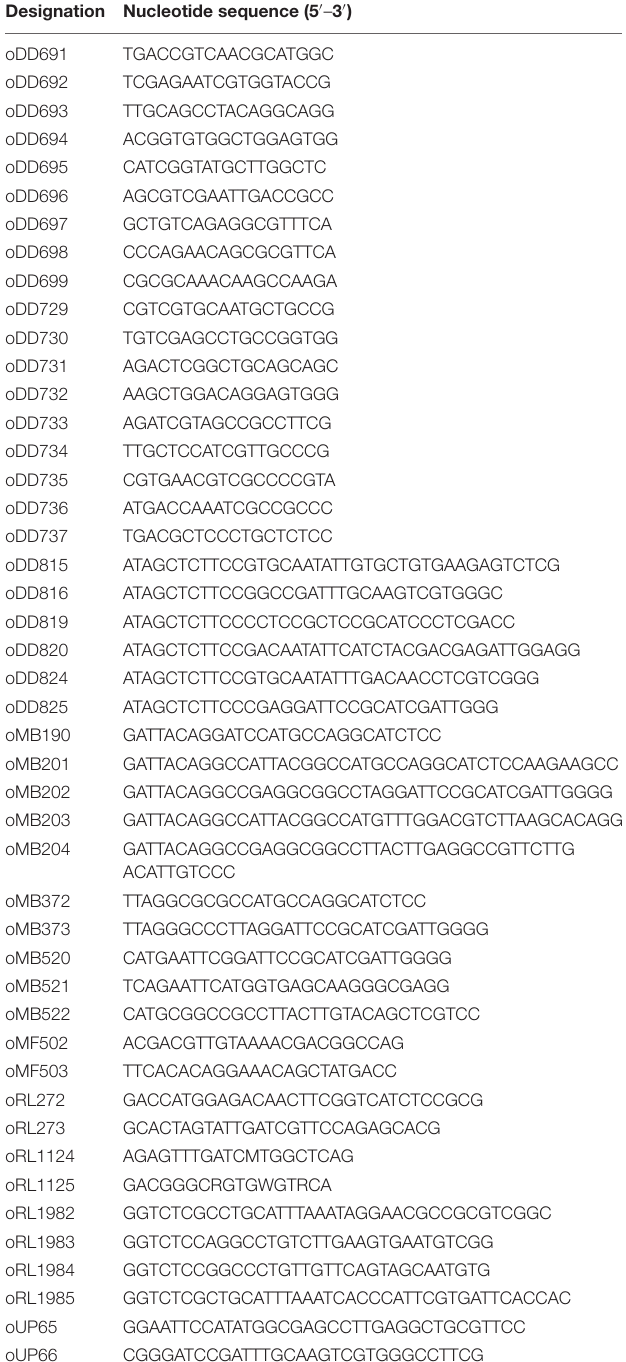
TABLE 2 | DNA oligonucleotides used in this study. Designation Nucleotide sequence (5 (cid:48) – 3 (cid:48)